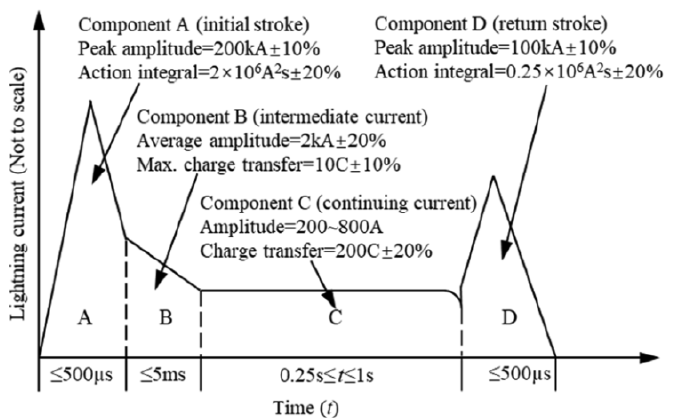
Figure 1. Lightning current waveform defined in [8].